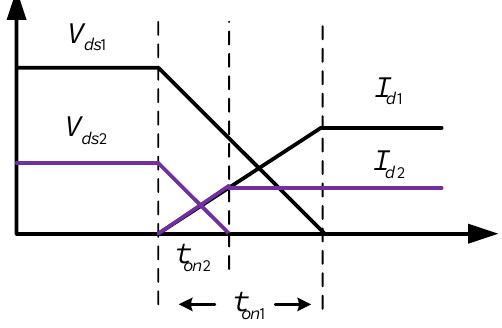
Figure 3. “ON” state switching transition.